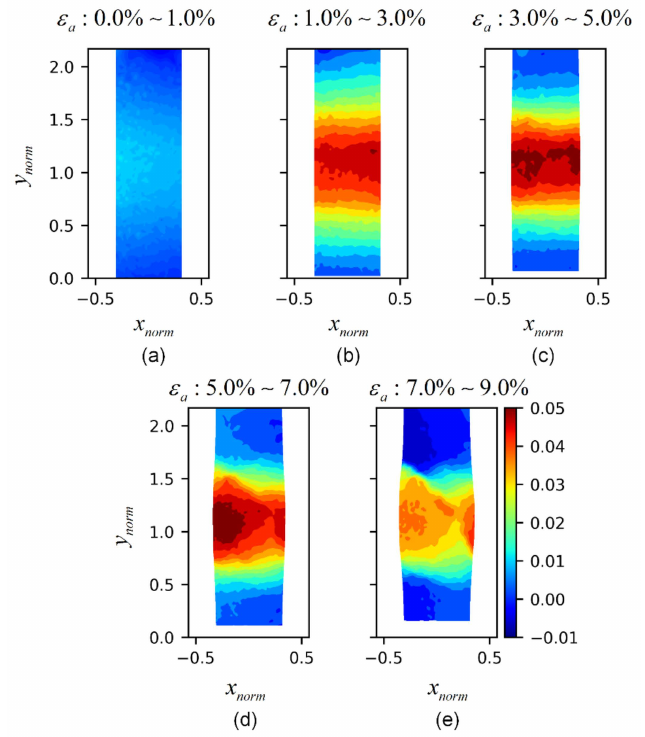
Figure 11. Evolution of gradient along ˆ ρ axis F 11 of test 092903b: ( a ) axial strain 0.0%–1.0%; ( b ) axial strain 1.0%–3.0%; ( c ) axial strain 3.0%–5.0%; ( d ) axial strain 5.0%–7.0%; ( e ) axial strain